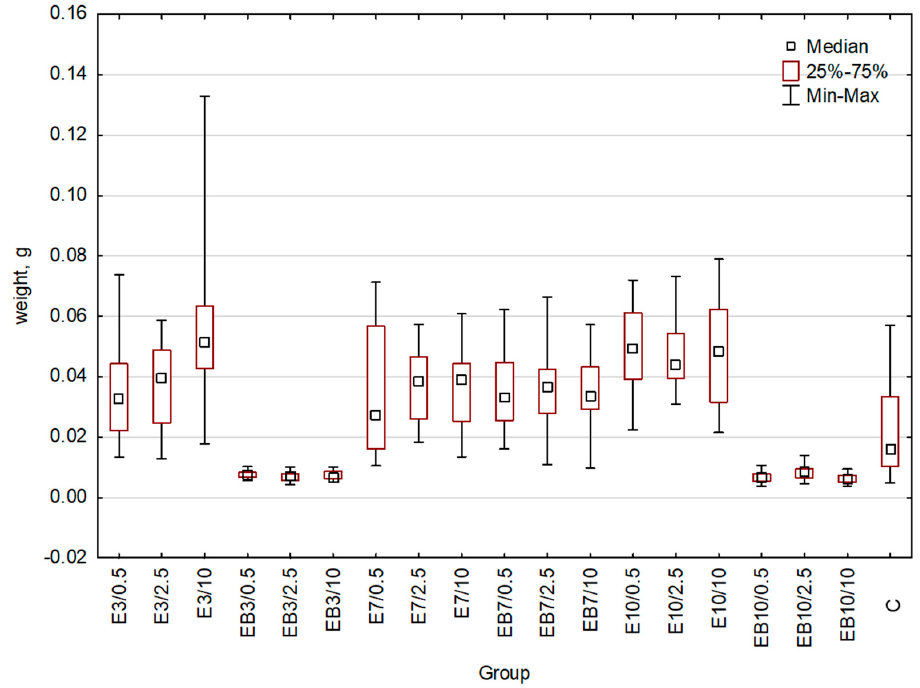
Figure 3. Wheat weight comparison: whiskers represent the maximum and minimum, the box represents interquartile range (25–75%), square denotes the median for the entire sample. C-control, E3-group treated with the aqueous extract obtained at 25 ◦ C pH = 3, E7-group treated with the aqueous extract obtained at 25 ◦ C pH = 7, E10-group treated with the aqueous extract obtained at 25 ◦ C pH = 10, EB3-group treated with the aqueous extract obtained at 75 ◦ C pH = 3, EB7-group treated with the aqueous extract obtained at 75 ◦ C pH = 7, EB10-group treated with the aqueous extract obtained at 75 ◦ C pH = 10. Concentrations used: 0.5-concentration 0.5%, 2.5-concentration 2.5%, 10-concentration 10%. Table 2. Fresh mass of the wheat treated with B. bassiana mycelium water extracts. Index *—indi- cates the presence of statistically significant differences between the control and tested groups.